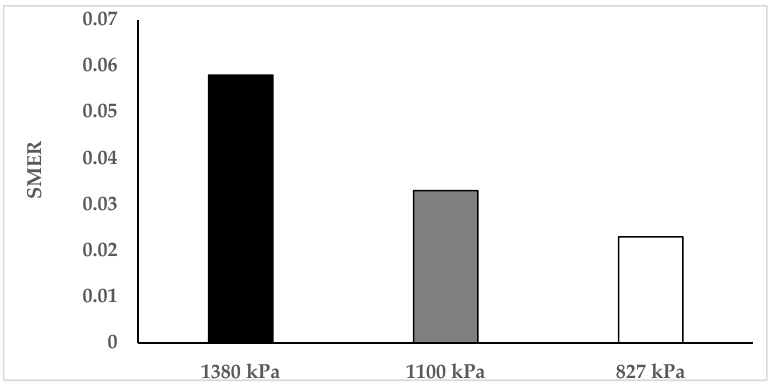
Figure 7. Specific moisture extraction rate.